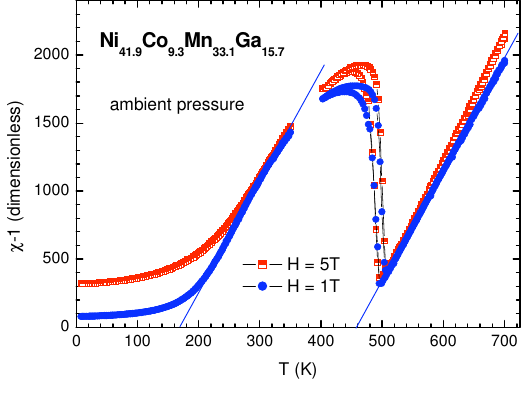
Fig. 4. The inverse susceptibility 